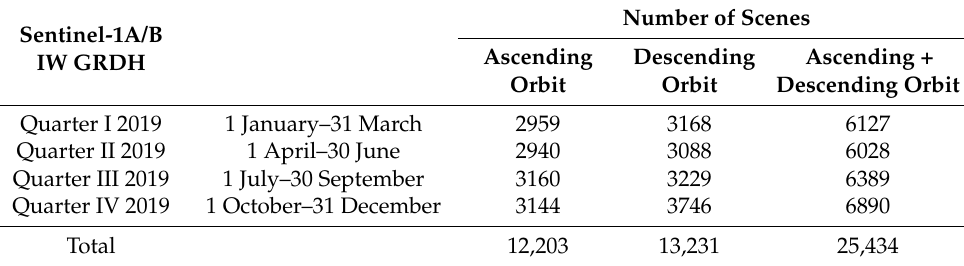
Table 2. Available Sentinel-1 IW GRDH scenes for the study region for the complete year 2019.